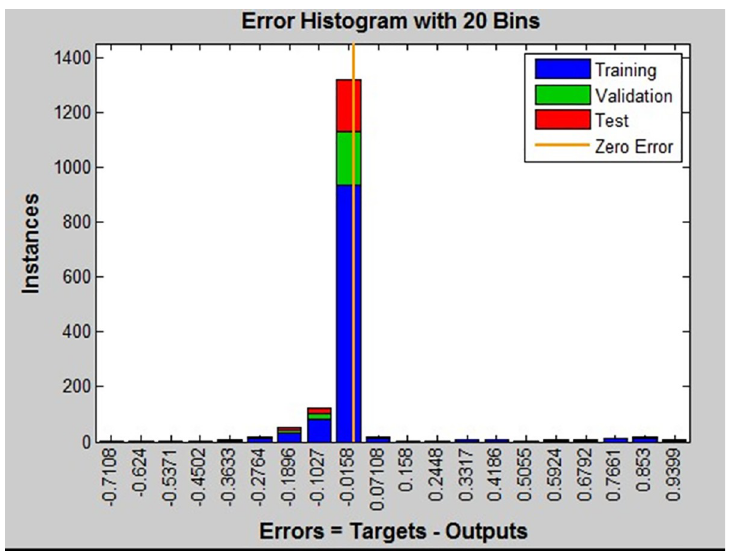
Fig 9. The gradient normalization errors of these